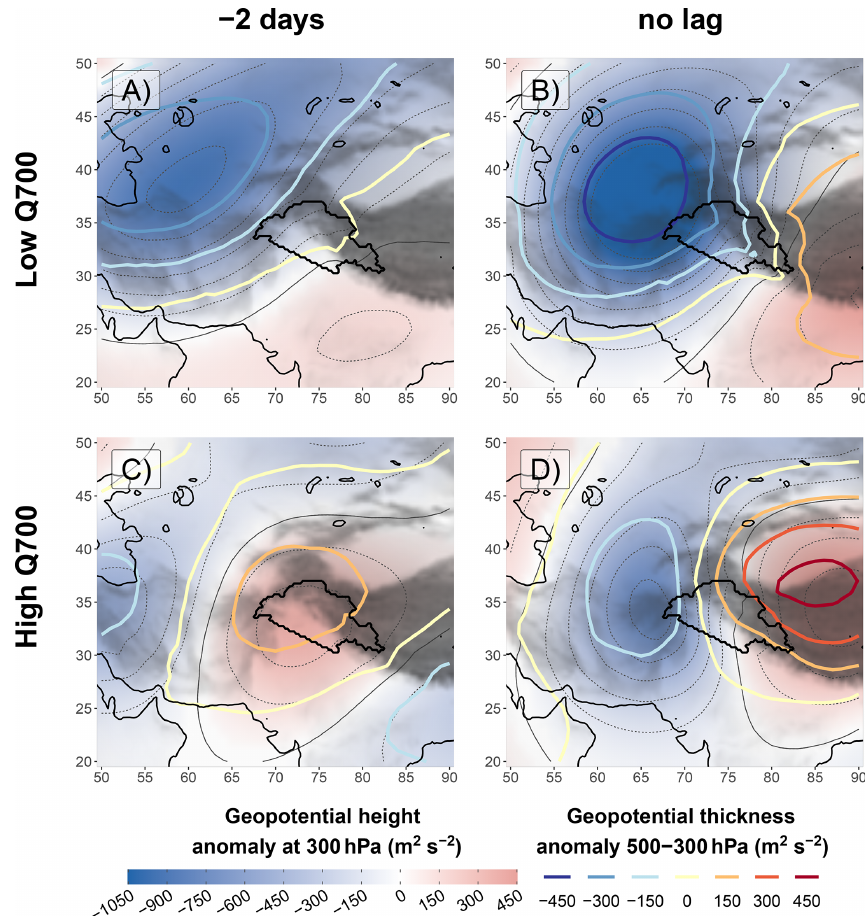
Figure 13. Same fields as in Fig. 3 but for composites based on the same selections as in Fig.